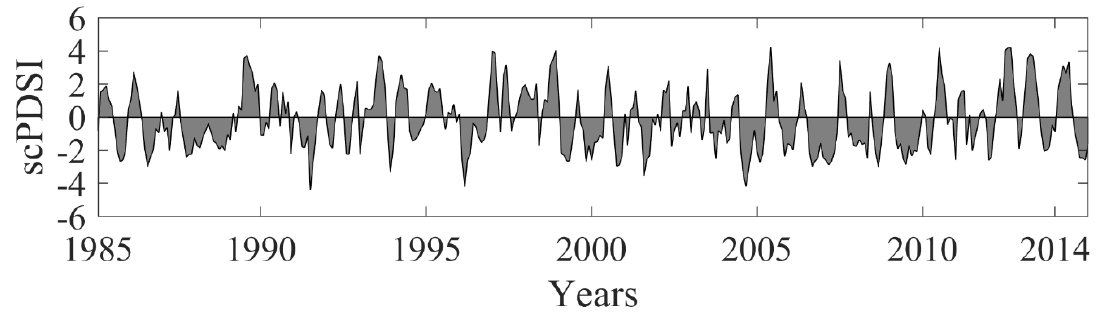
Figure 14. Drought duration maps for historic observed data for study area BK. ( a ) for severe drought and ( b ) for extreme drought. The scale bar represents months of drought in historic 30 years (1985 – 2014).